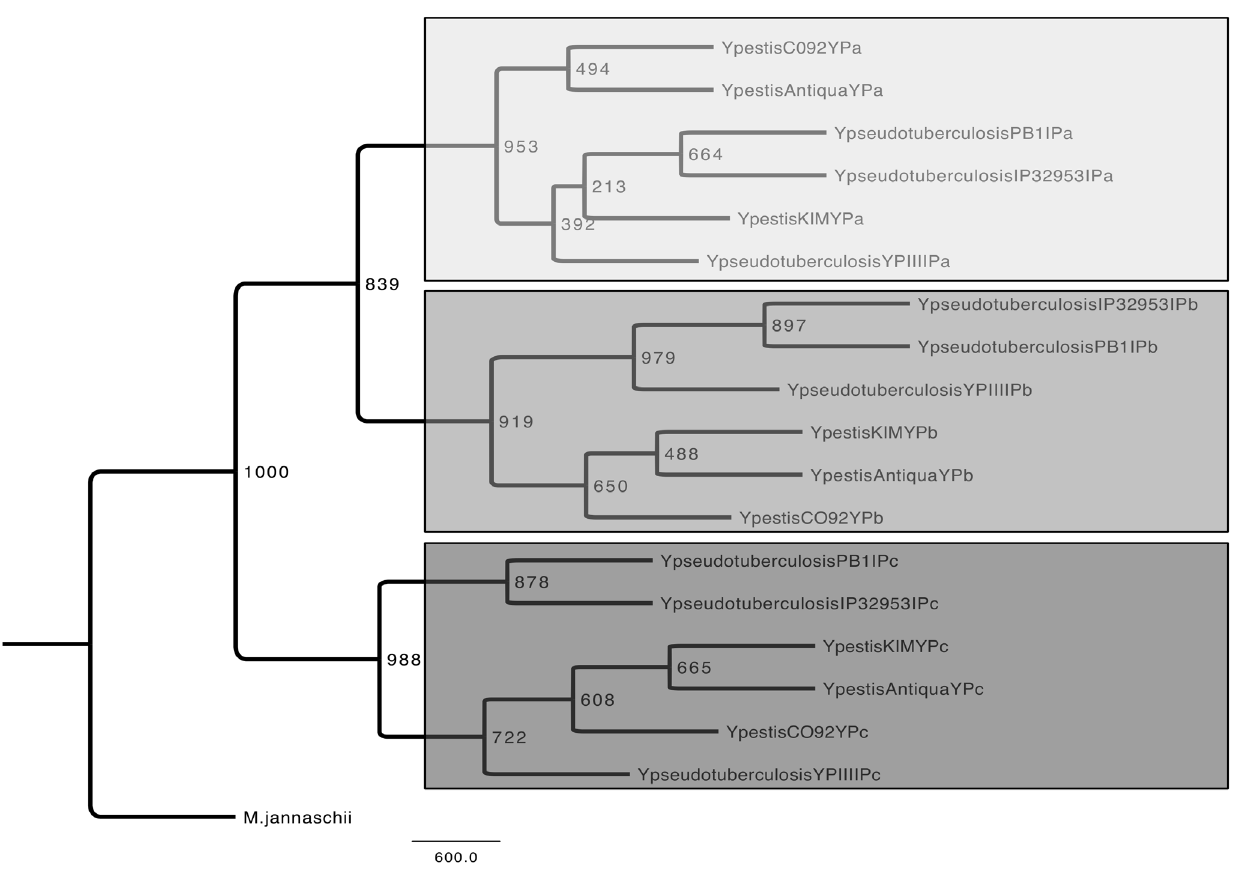
Figure 4. Tree generated by the alignment of 18 leader sequences of CRISPR loci of Yersiniapestis and Yersiniapseudotuberculosis . I, II, III – main groups: YPa, YPb and YPc loci of Y. pestis and Y. pseudotuberculosis . A - important branch in the emergence of the YPa and YPb loci; B - unique branch in the emergence of the YPc locus.